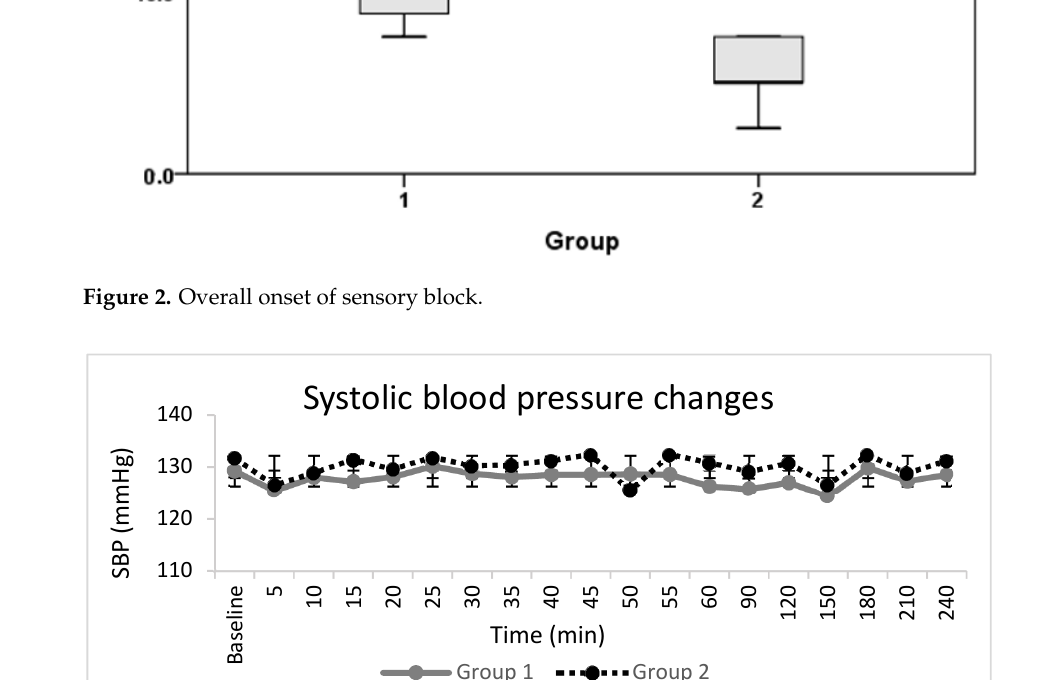
Figure 3. Systolic blood pressure changes (SBP). The line graphs represent the mean and standard deviation in Group 1 and Group 2.